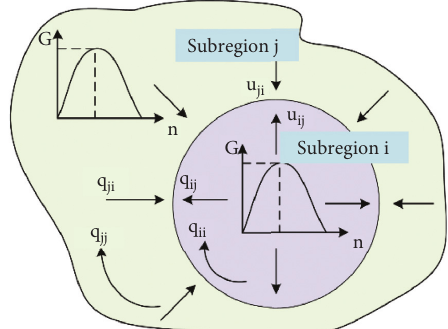
Figure 7: Schematic diagram of traffic flow in the road network